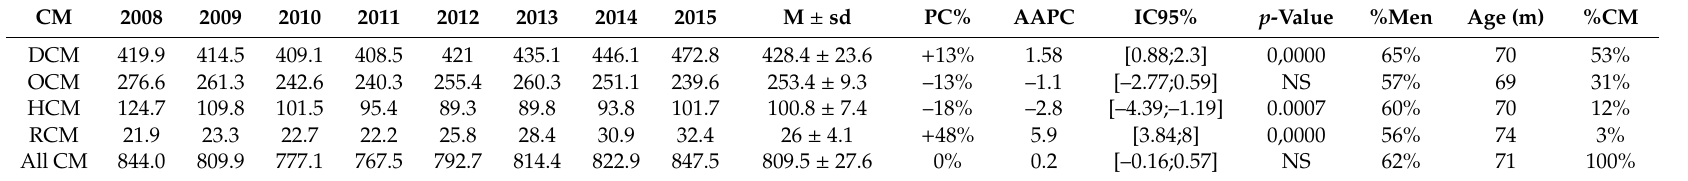
Table 1. Inpatient prevalence of patients (PMI) with cardiomyopathies in France over the period